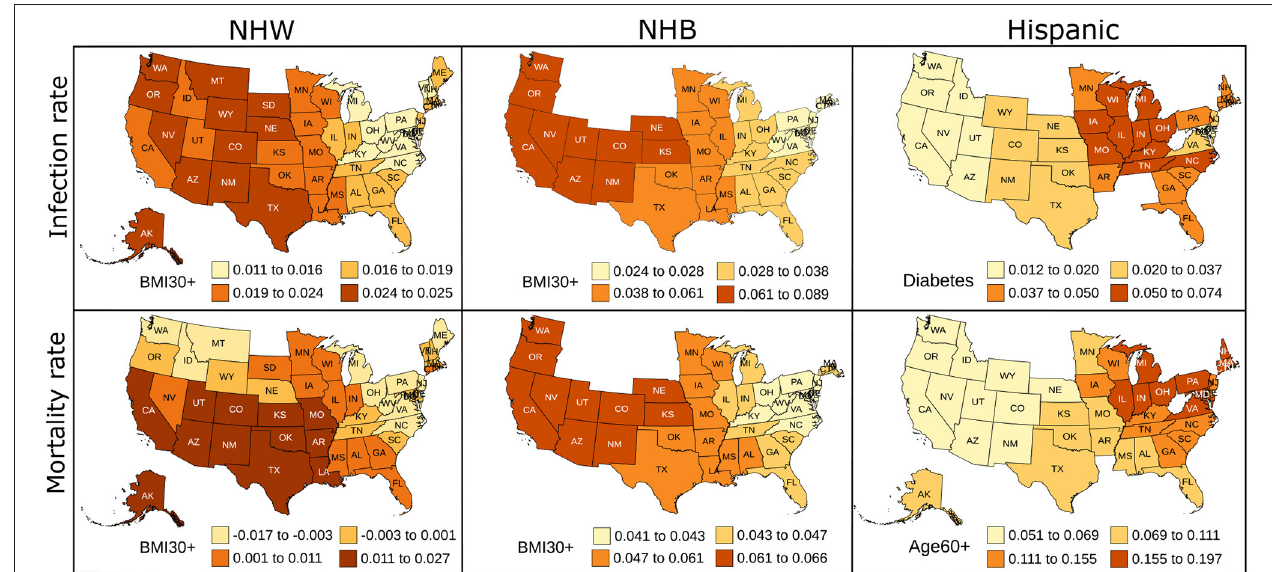
FIGURE 4 | Map showing the coefficient values for the most significant variables for the GWR models constructed on predictors used in linear regression for NHW, NHB, and Hispanics data. The states with no color indicate that the ethnicity-wise data on the corresponding risk factors was not available in those states.